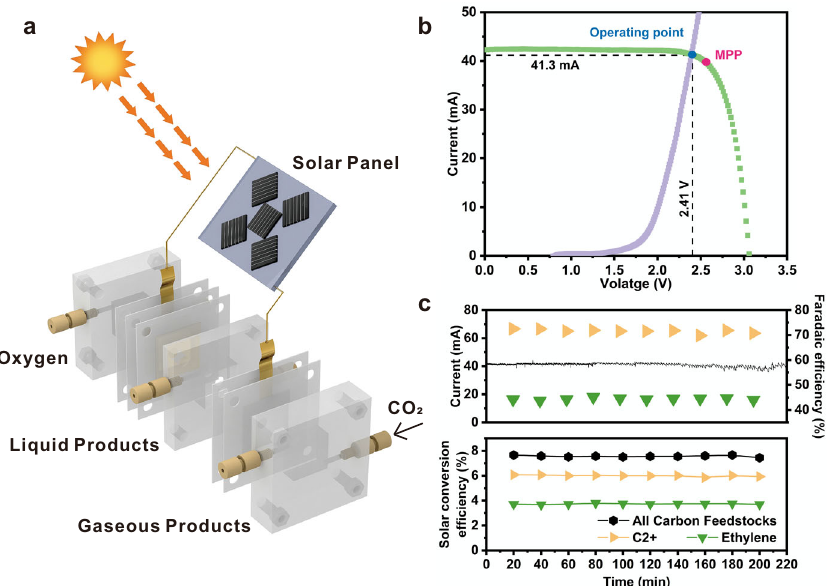
Fig. 4 Solar-powered CO 2 reduction. a Schematic of the PV-EC system. b Photovoltaic and electrocatalytic I-V behaviors. The photovoltaic performance is shown under light (green) with the MPP marked by a red dot. The measured operating current of the CO 2 electrolysis system (cathode, anode, and anion exchange membrane) at different voltages has been marked by the purple curve. The observed long-term operating point is marked by a blue dot, with the black dashed lines showing the corresponding current and voltage. c Faradaic ef fi ciency towards ethylene and C2 + products, solar current, and solar conversion ef fi ciency as a function of reaction time. Carbon feedstocks include CO, methane, ethylene, ethanol, and n-propanol. C2 + products include ethylene, ethanol, and